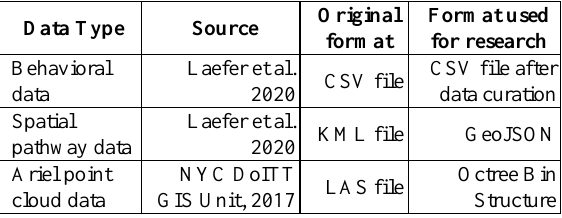
Table 1 . Data types and their